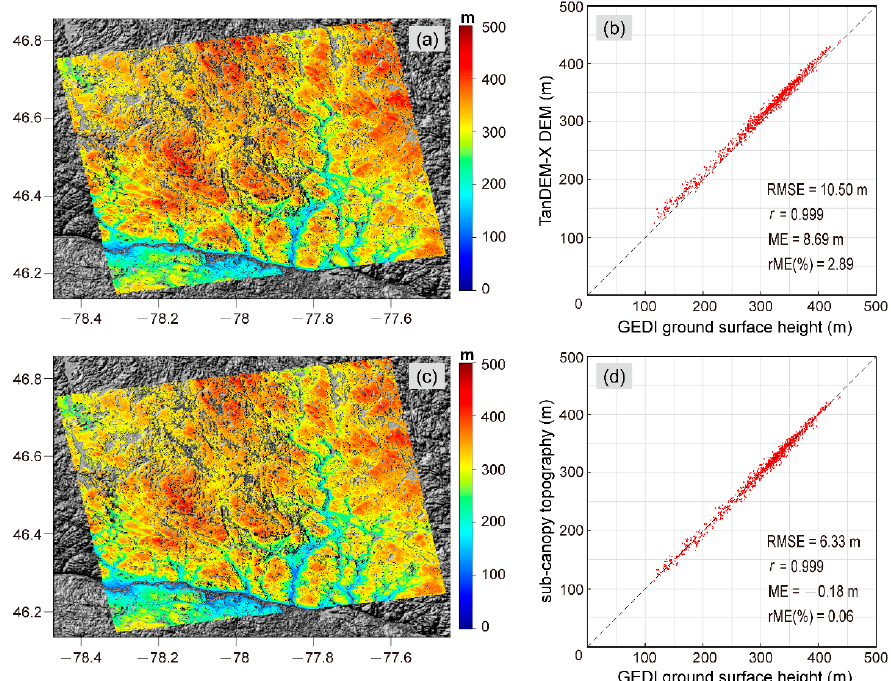
Figure 11. ( a ) Original TanDEM-X DEM; ( b ) Scatterplot comparison between the original TanDEM-X DEM and the GEDI ground surface elevation; ( c ) Sub-canopy topography; ( d ) Scatterplot comparison between the sub-canopy topography and the GEDI ground surface elevation.